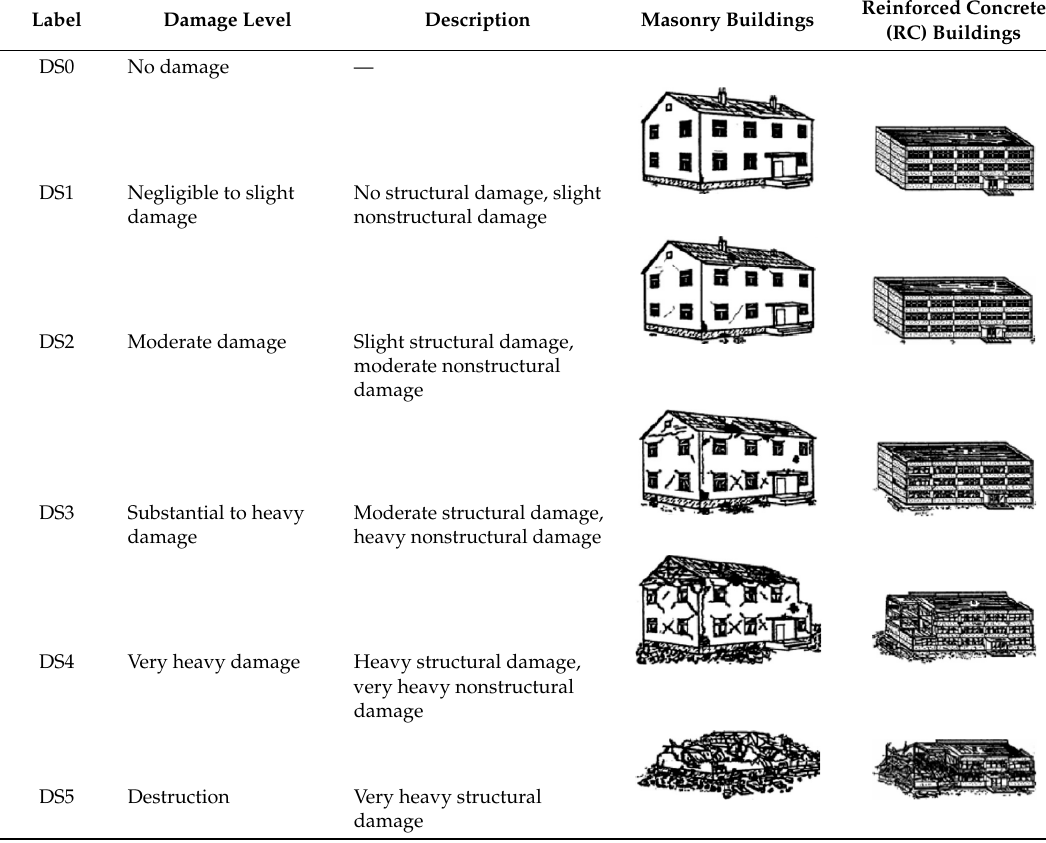
Table 1. Damage scale adopted in [23] to compute the typological seismic risk.